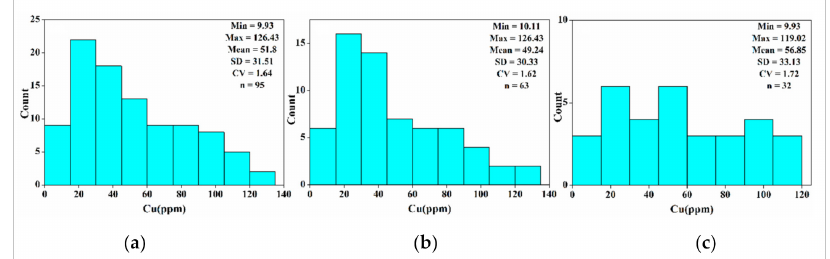
Figure 6. Cu element content statistical description and histograms, ( a ) all of the samples; ( b ) training samples; ( c ) verification samples; Min: minimum; Max: maximum; SD: standard deviation, CV: coe ffi cient of variation.